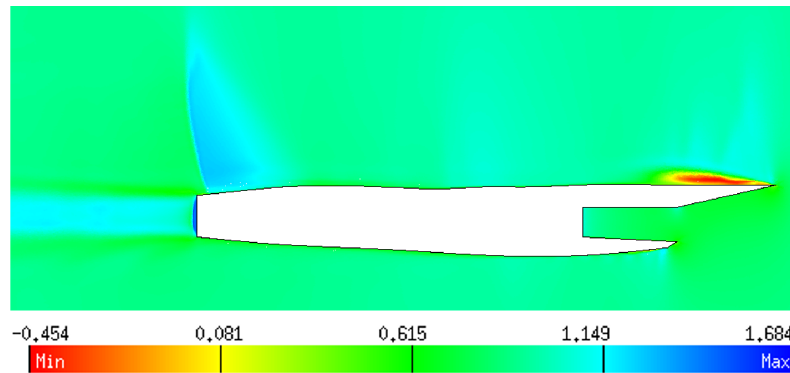
Figure 17. Iso-contours of the streamwise velocity at y / L y = 0.15 (flow from right to left).